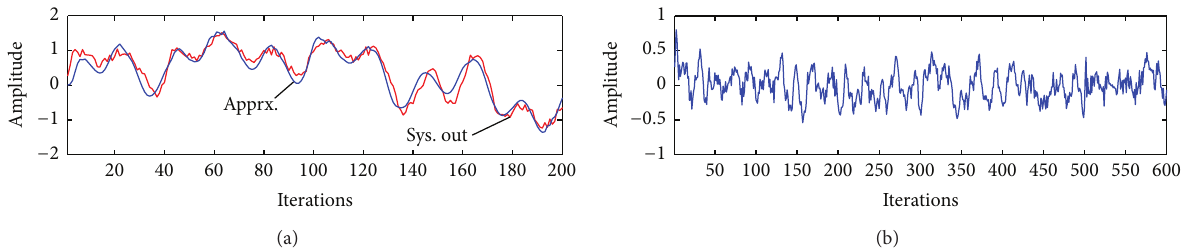
Figure 11: The simulation result with DR-LMS algorithm. (a) Process of identification. (b) Error of